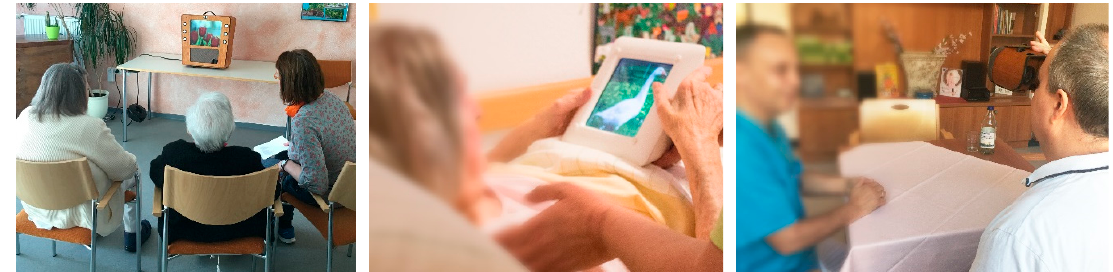
Figure 1. The pictures show prototypes for reminiscence therapy with people with dementia being tested in a nursing home and a daycare facility. Left to right: the “Jukebox”, the “Pyramid”, and the “Binoculars”.